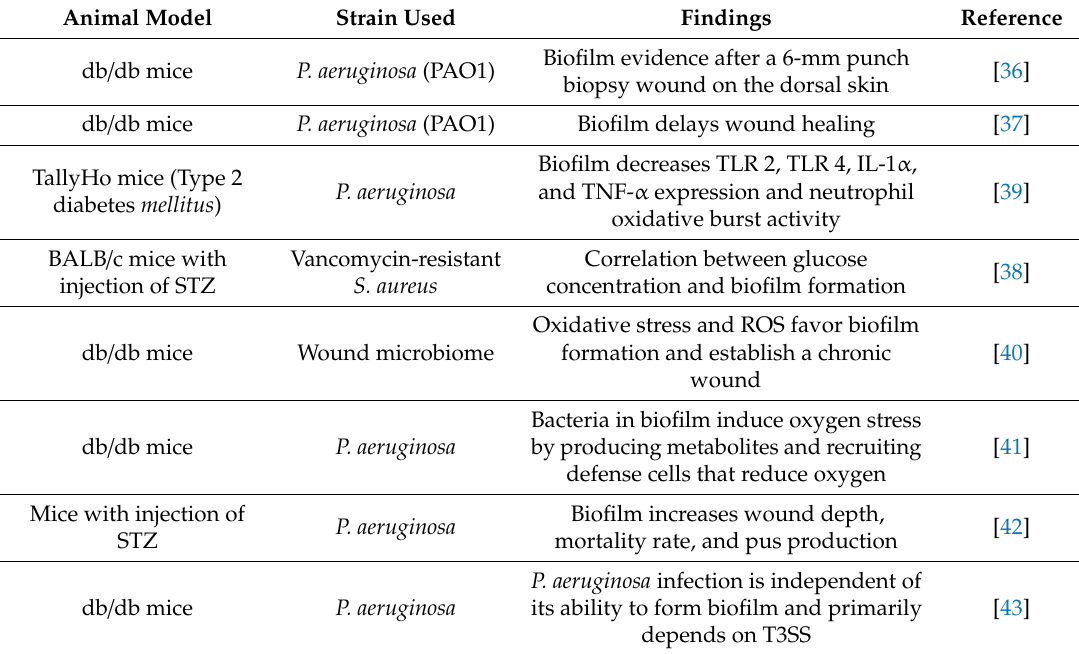
Table 1. Examples of biofilm studies in animal models of